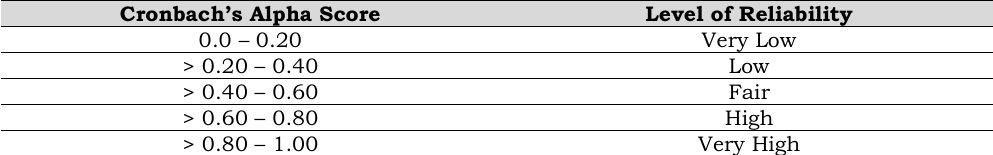
Table 1. Level of standard